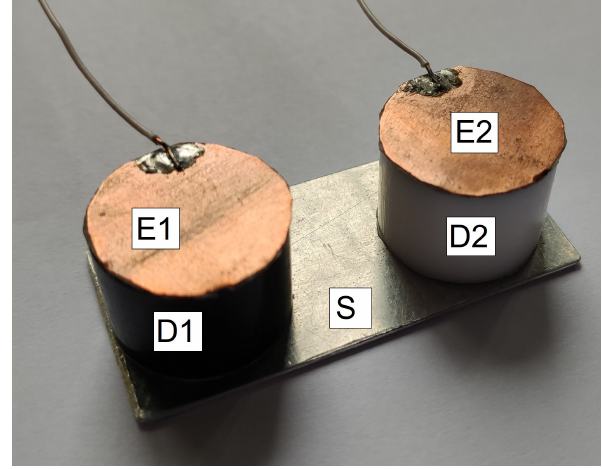
Figure 6. A laboratory model of a sensor. Marking corresponds to the one from Figure 2.